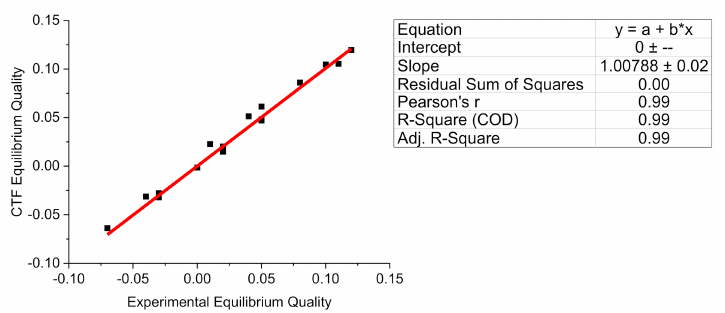
Figure A3. CTF vs. experimental equilibrium